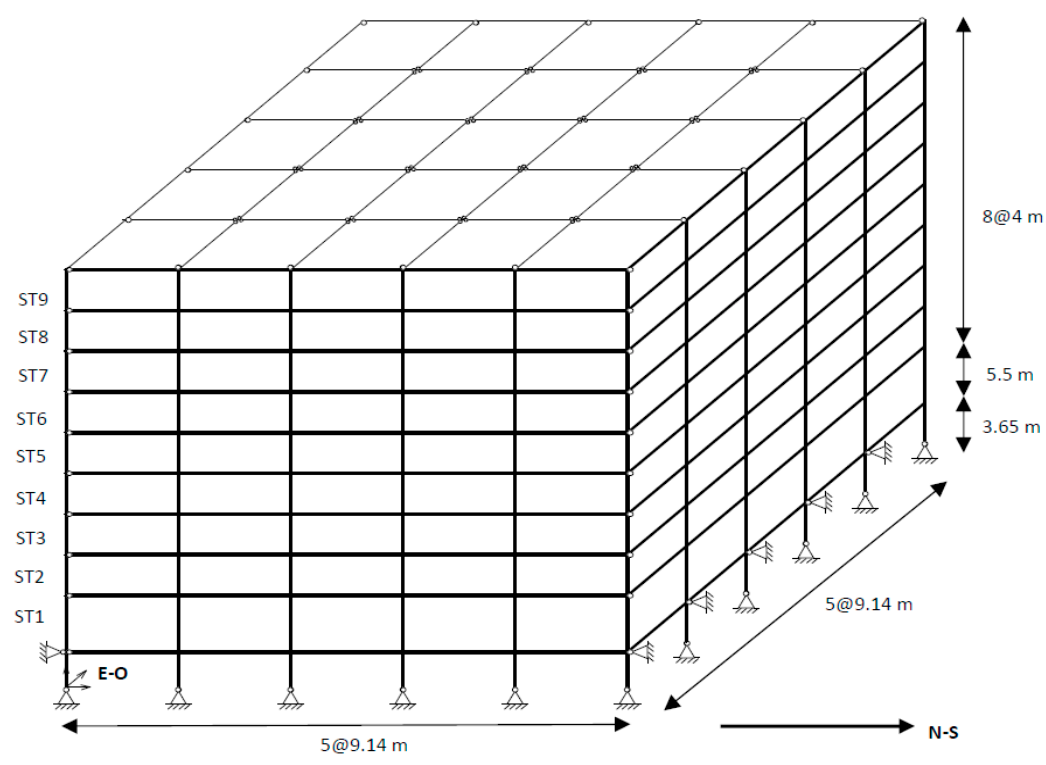
Figure 2. Isometric view of the 9-level building. Table 2. Earthquake records, NS component. T n : Elastic period; ED: epicentral distance; M: Magnitude moment; PGA: Peak ground acceleration.